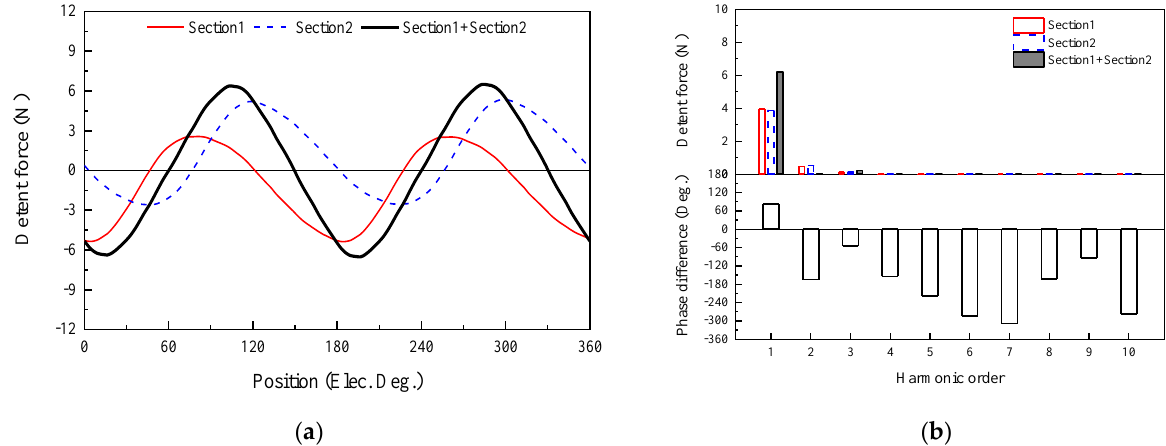
Figure 5. Detent force of Model 1: ( a ) detent force waveforms by sections; ( b ) detent force frequency decomposition.